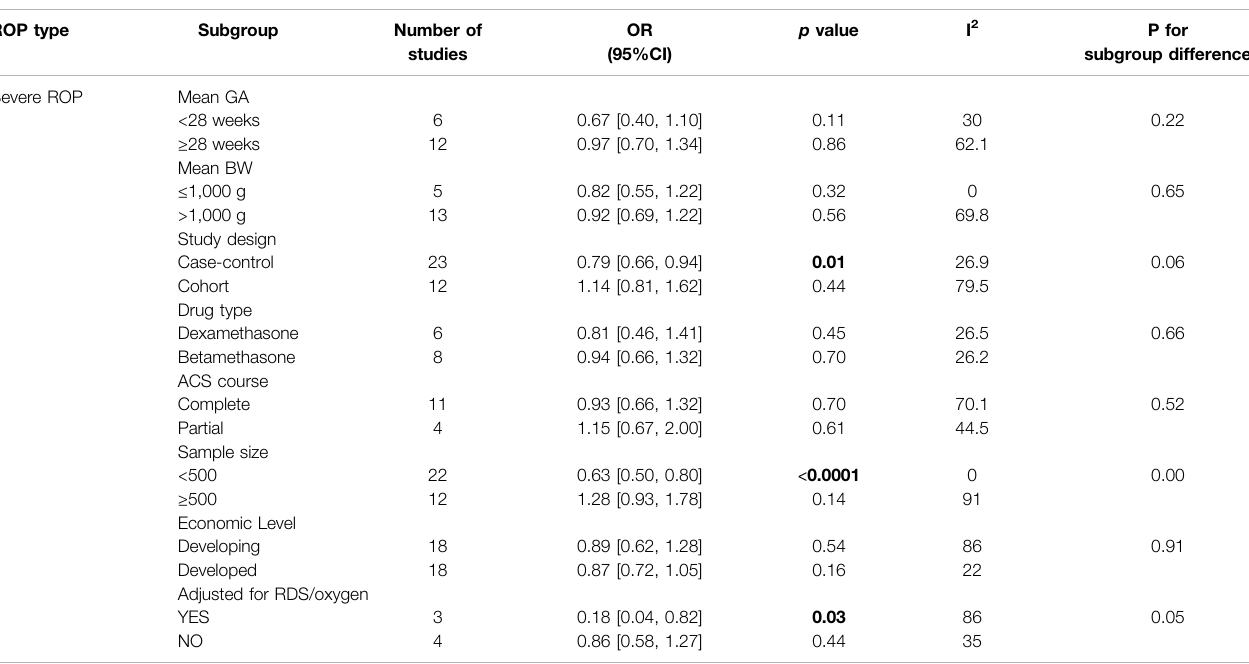
TABLE 2 | Subgroup analysis of severe ROP risk in the ACS-exposed group. ROP type Subgroup